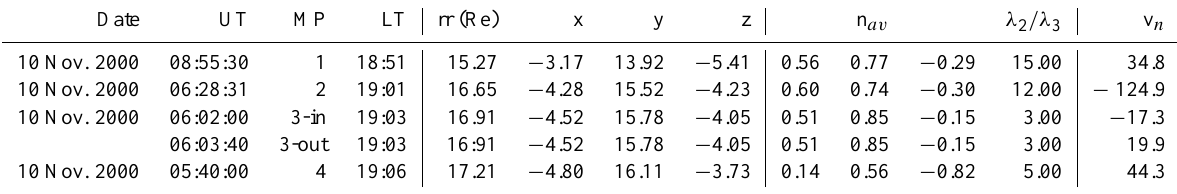
Table 1. Boundary analysis